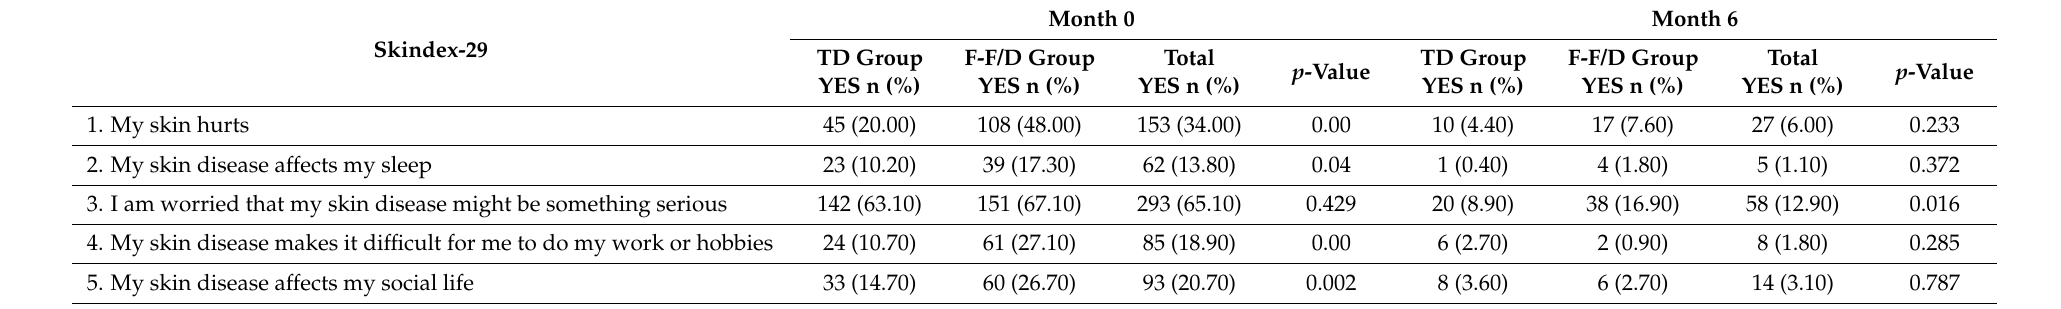
Table 4. Changes in HRQoL between baseline and 6 months after the first visit, across Skindex-29